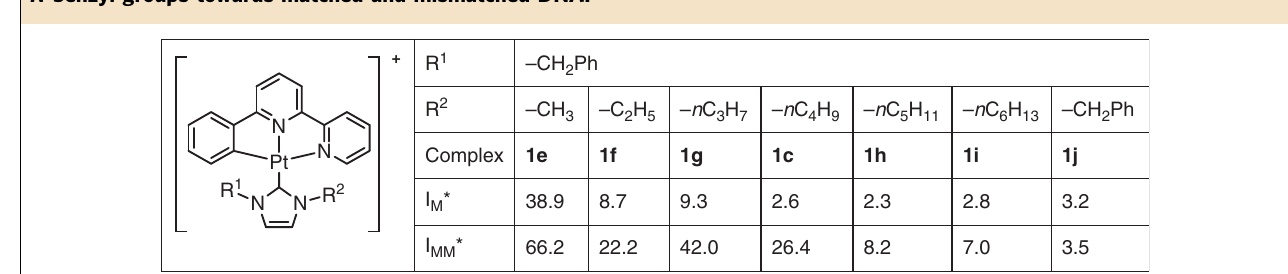
Table 1 | A comparison of structure–emission response relationships of [Pt(C^N^N)(NHC)]CF 3 SO 3 complexes containing N -benzyl groups towards matched and mismatched